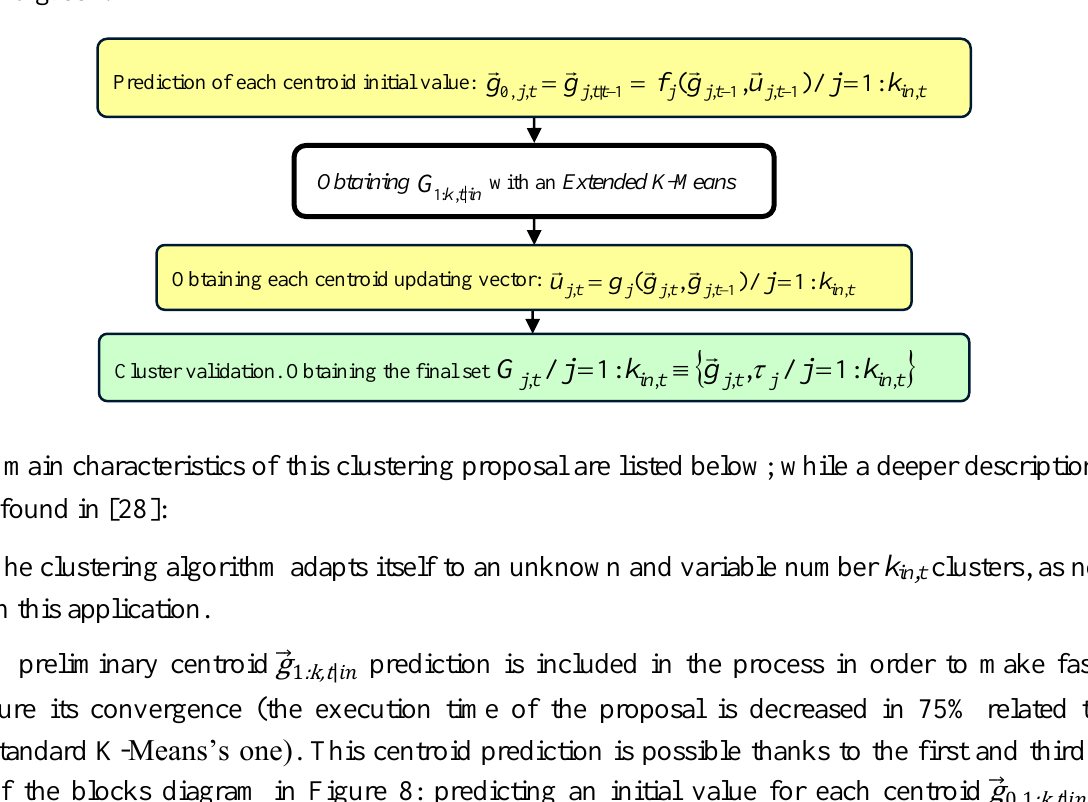
Figure 8. Functional diagram of the modified version of the Extended K-Means (second step, white background), used in the correction step of the XPFCP: the Sequential K-Means with Validation . New steps of this clustering algorithm are highlighted in yellow and